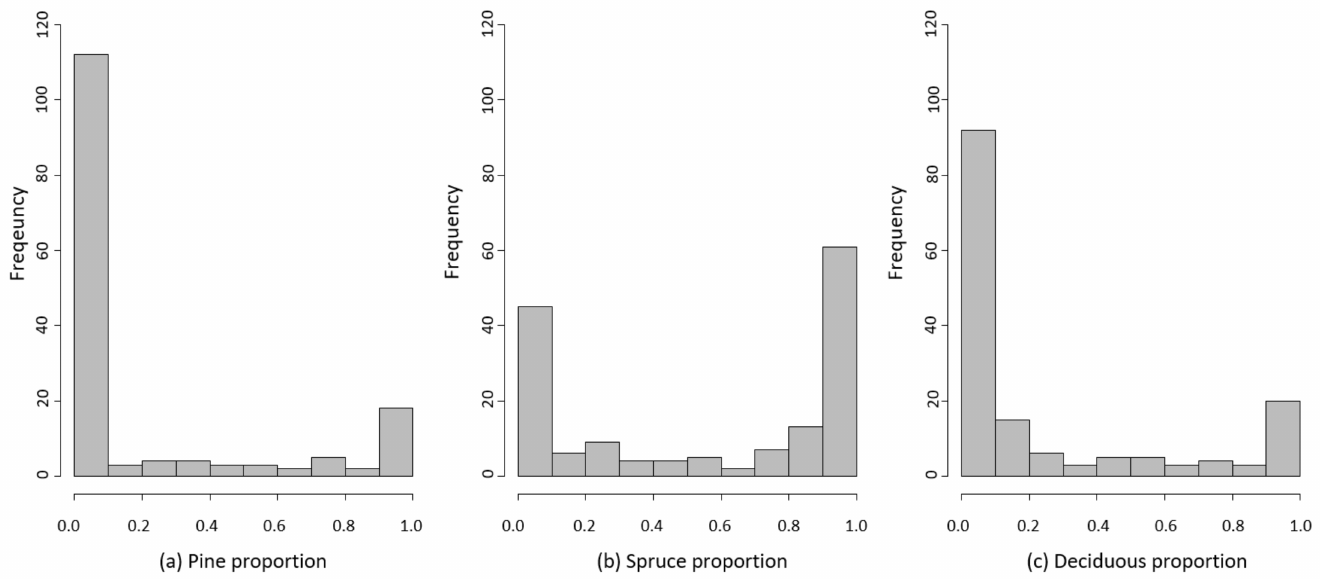
Figure 2. Histogram showing field surveyed species proportions of mean stem volume for ( a ) pine, ( b ) spruce and ( c ) deciduous trees at 156 plots, in 10% interval classes as is common in Swedish forest management